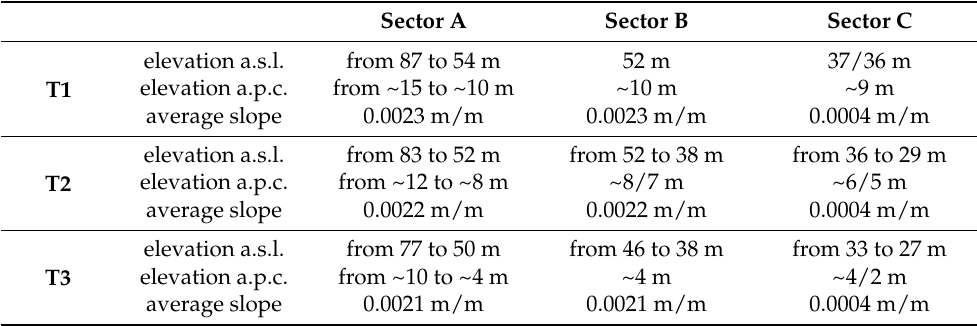
Figure 7. Stratigraphical logs of boreholes drilled through the T1 and T2 VFT (For location seethe geomorphological sketches).